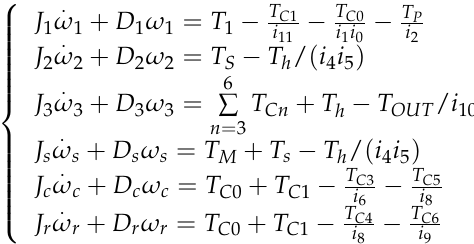
Figure 4. HMCVT simulation system diagram.